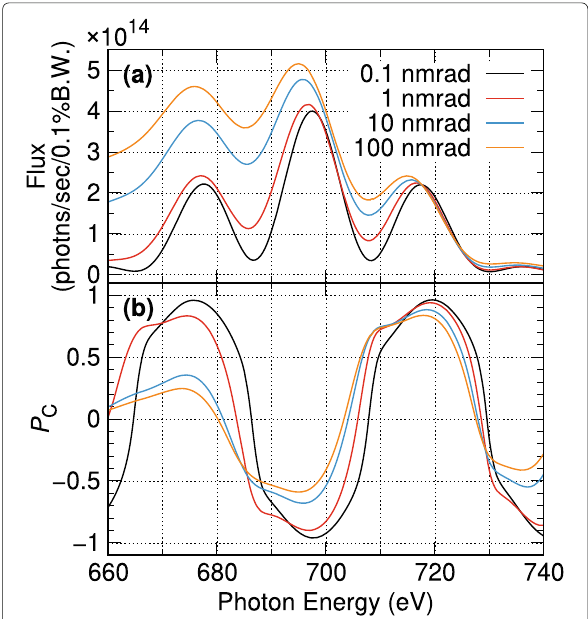
Fig. 30 Emittance effect on the energy spectra and the degree of CP.